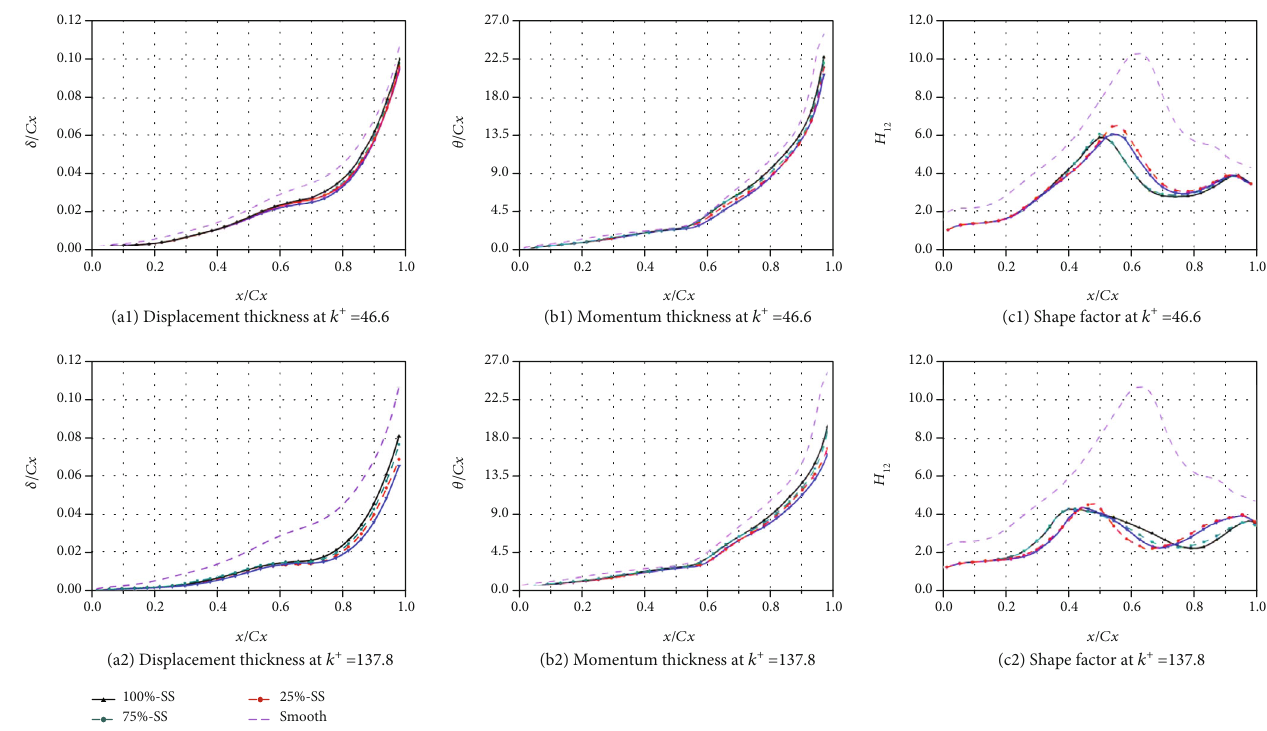
Figure 22: Boundary layer parameters at 50% span of the rotor suction side versus roughness locations at k + = 46 : 6 and 137.8.